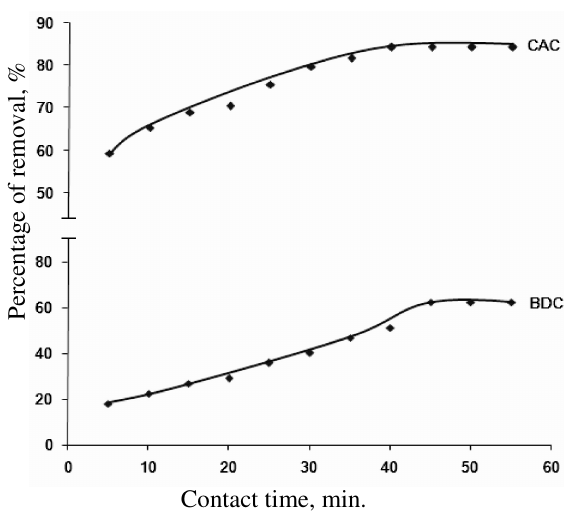
Figure 2. Effect of contact time on the removal of lead(II) ions by BDC and